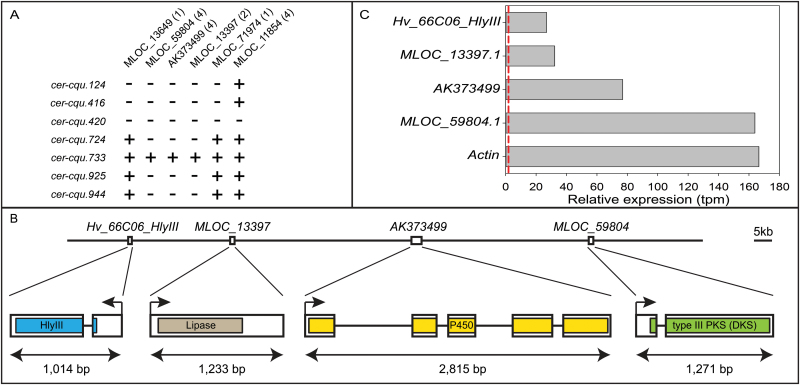

Cer-cqu candidate genes, barley BAC sequence and gene expression. (A) PCR amplification of six candidate genes using DNAs from barley cer-cqu triple mutants as templates. The inability to amplify MLOC_59804, MLOC_13397 and AK373499 from six mutants pinpointed these as Cer-c, Cer-q and Cer-u candidates. The number of primer pairs used with each gene is in parenthesis. +, gene amplified; -, gene not amplified. (B) Proposed order and gene models of the four genes identified on barley BAC HVVMRXALLrA0066C06. Regions encoding conserved domains are colored. Bar, 5kb. (C) Relative expression of the four genes based on RNA-seq analysis of barley flag leaf sheath (SRA PRJEB12101). Actin (MLOC_54382.1) is included as a reference gene. The dashed red line corresponds to a transcripts per million (tpm) value of 2, commonly used as the cut-off for real expression over noise.